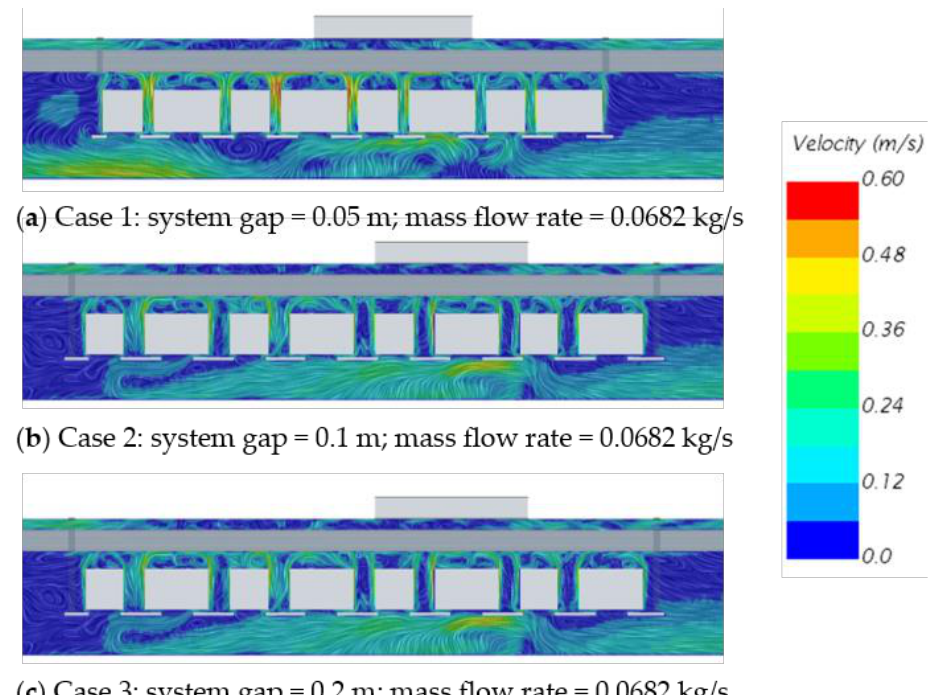
Figure 14. Velocity contour for Cases 1, 2, and 3 of the underfloor equipment bay (Configuration 2) for increasing gap distances and a constant mass flow rate.